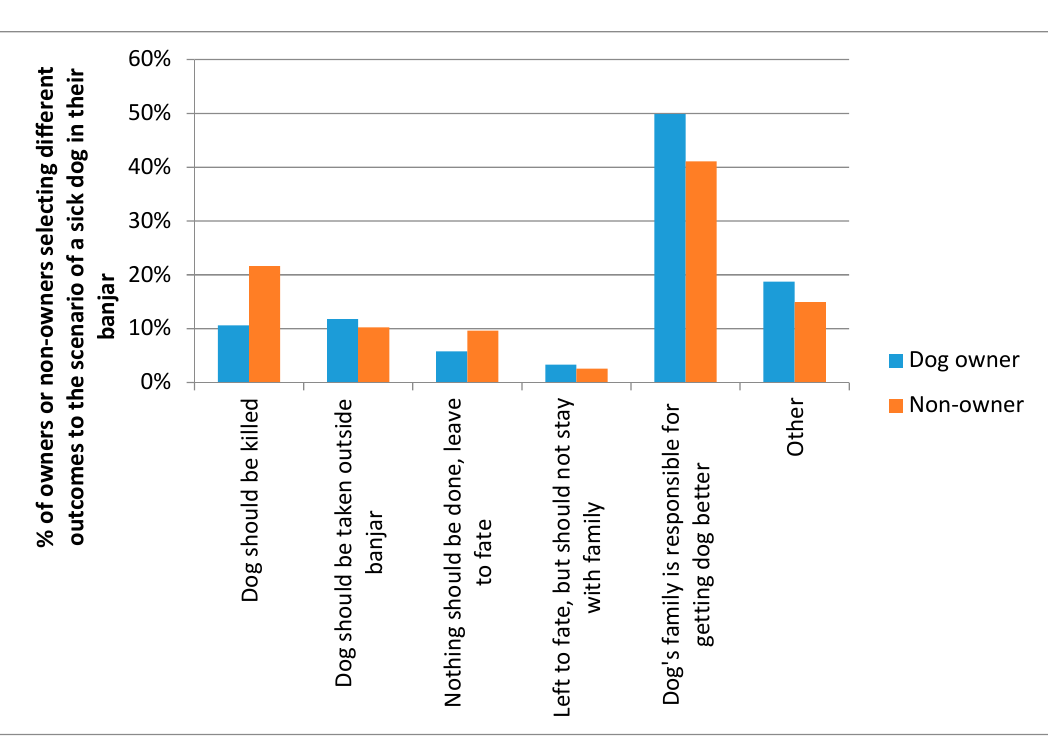
Figure 12. Dog owner and non-owner responses to what should be done in the scenario of a sick dog in their banjar .